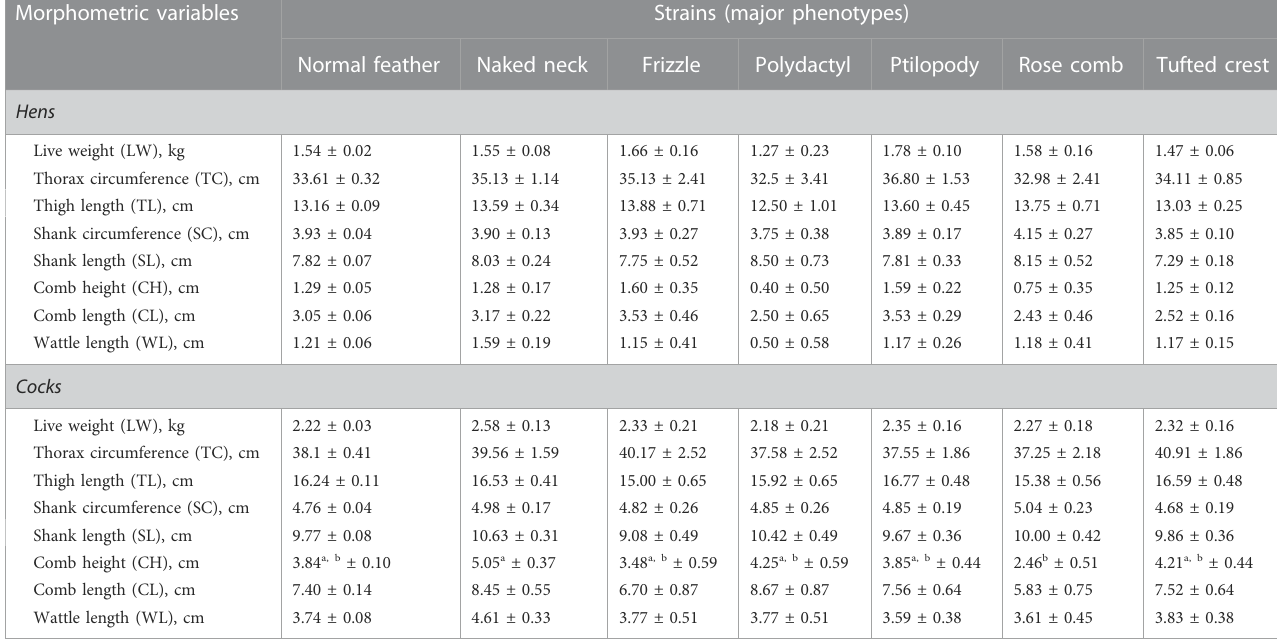
TABLE 8 Least-square means (LSM ±S.E) of morphometric measurements among the strains of the indigenous chicken population in Uganda. Morphometric variables Strains (major phenotypes) Normal feather Naked